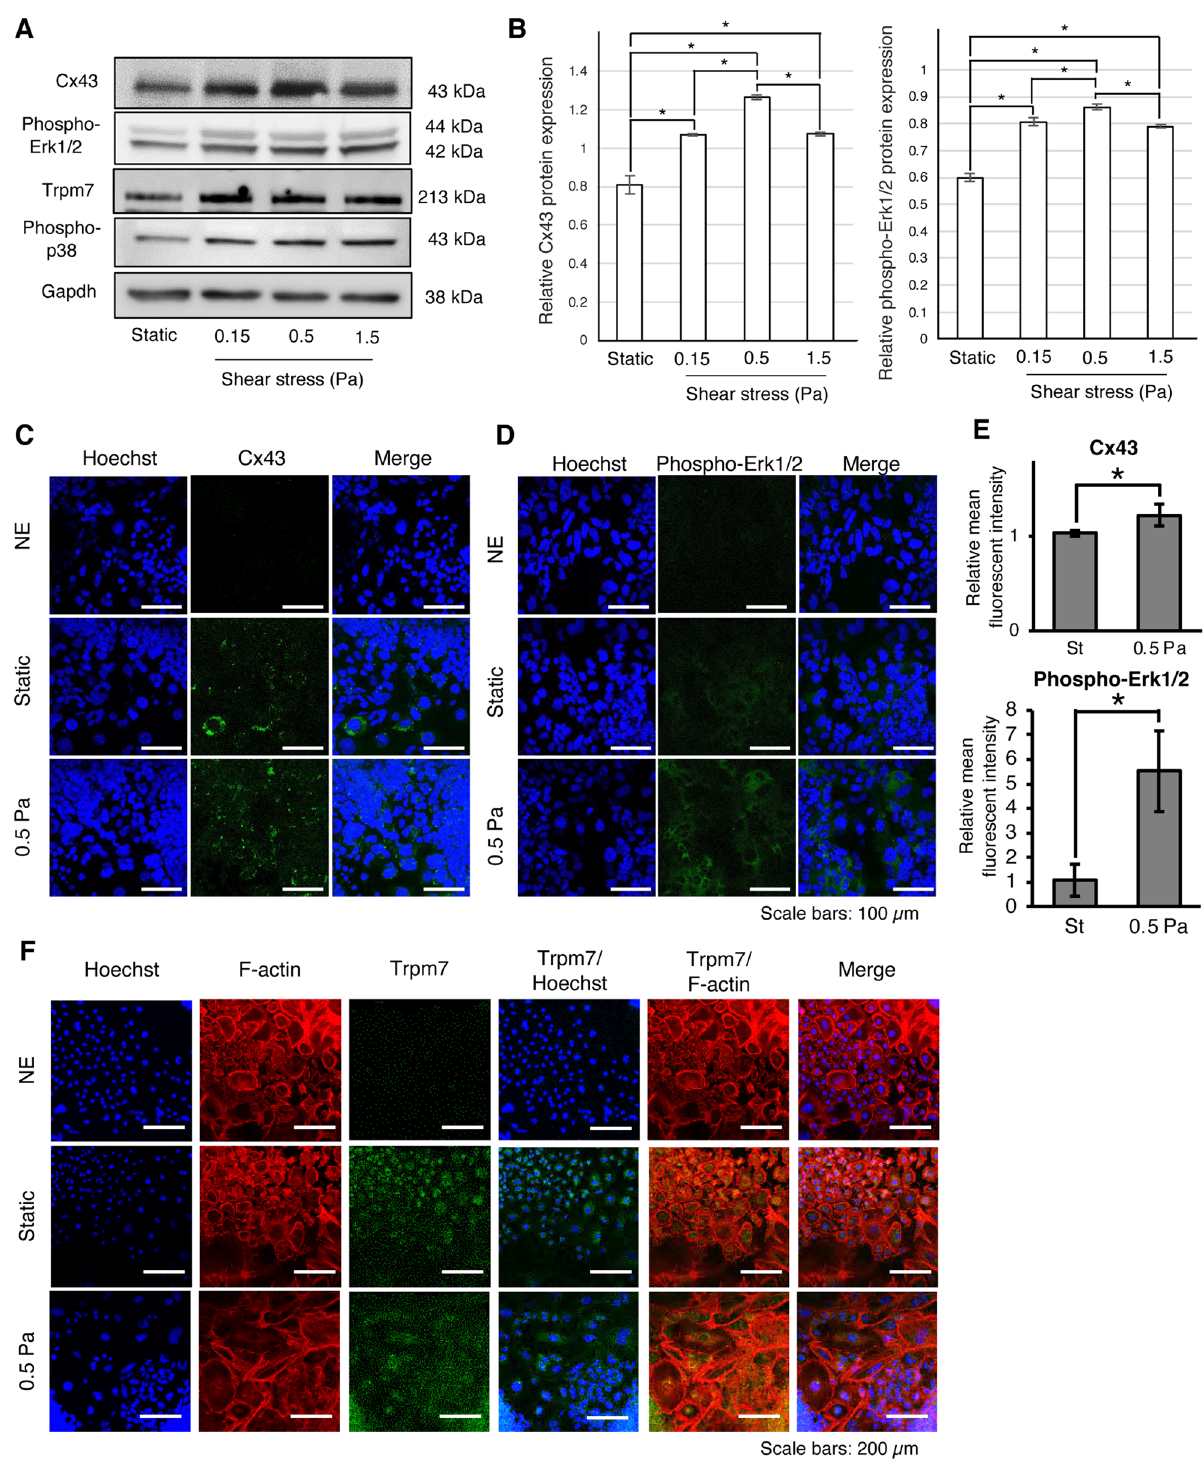
Figure 4. Mechanisms involved in continuous shear stress-enhanced osteogenic differentiation of iPSCs. iPSCs were analyzed after being subjected to shear stress for 48 h. ( A ) Western blot analysis of cell surface channels Connexin 43 (Cx43) and Trpm7 as well as the phosphorylation of downstream factors including Erk1/2 (phospho-Erk1/2) and p38 (phospho-p38). Original blots are presented in Supplementary Fig. 6. ( B ) Quantitative analysis of Cx43 and phospho-Erk1/2 expression using ImageJ software. The expression levels were normalized to Gapdh expression. *: P < 0.05, ANOVA with Tukey’s multiple comparison test. Representative data from three independent experiments are shown (mean values ± SD: n = 3). Immunofluorescence analysis was performed to detect the protein expression and localization of ( C ) Cx43 (green), ( D ) phospho-Erk1/2 (green), and ( F ) Trpm7 (green). Normal mouse IgG and normal rabbit IgG were used as a negative control (NC). The cytoskeleton (F-actin; red) and nuclei (blue) were stained using rhodamine- phalloidin and Hoechst, respectively. Scale bars: ( C and D ) 100 μm, ( F ) 200 μm. ( E ) The relative mean fluorescence intensity of Cx43 and phospho-Erk1/2 was quantified by ImageJ software. *: P < 0.05, Student’s t -test. Data represent the mean ± SD (n =